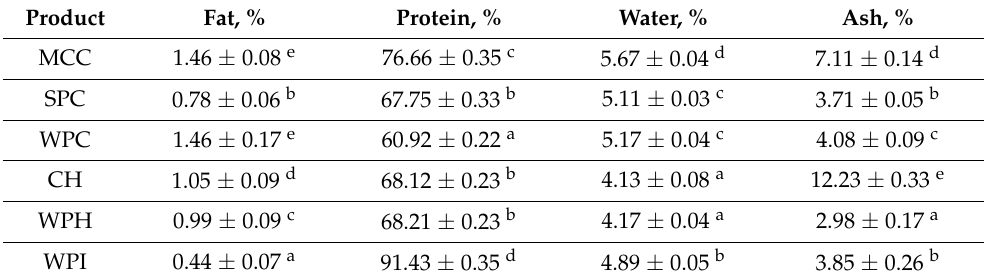
Table 1. Proximate composition of high-protein milk powders.